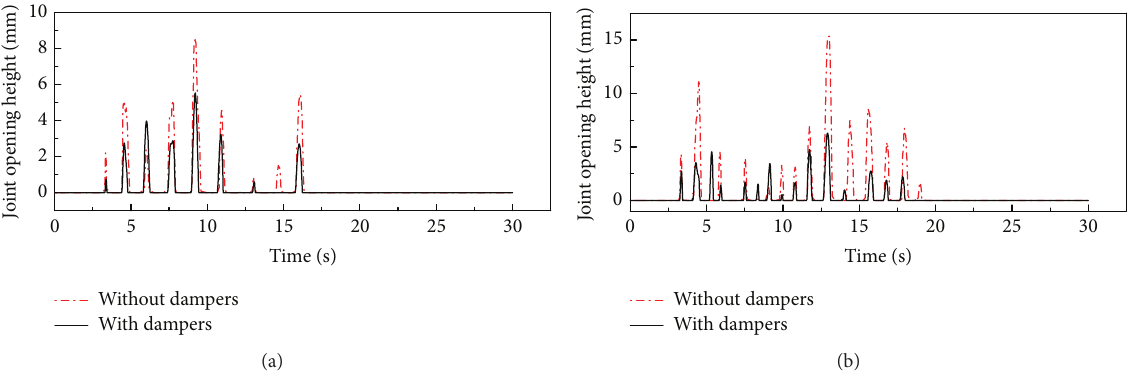
Figure 13: Opening height of the joint: (a) longitudinal direction; (b) transverse